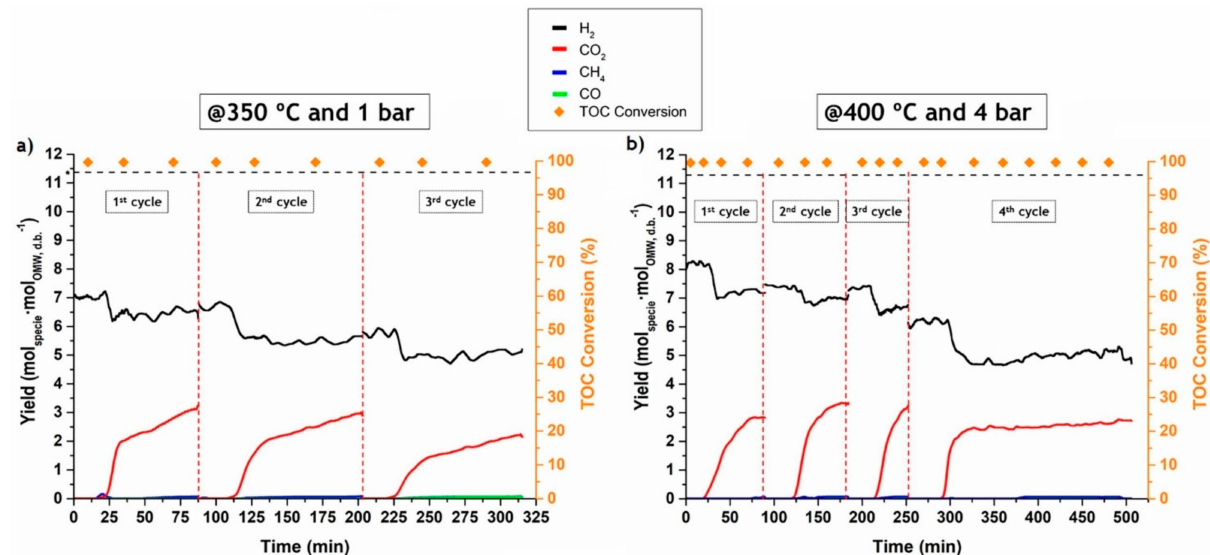
Figure 15. Gaseous species yield and TOC conversion using an SER at ( a ) 350 ◦ C and 1 bar or ( b ) 400 ◦ C and 4 bar. * Thermodynamic equilibrium for the H 2 yield in a TR at the operations conditions used in the respective experiments (dashed horizontal line). Dashed red vertical lines indicate instants of reactive regeneration. Reprinted with permission from Ref. [197]. Copyright